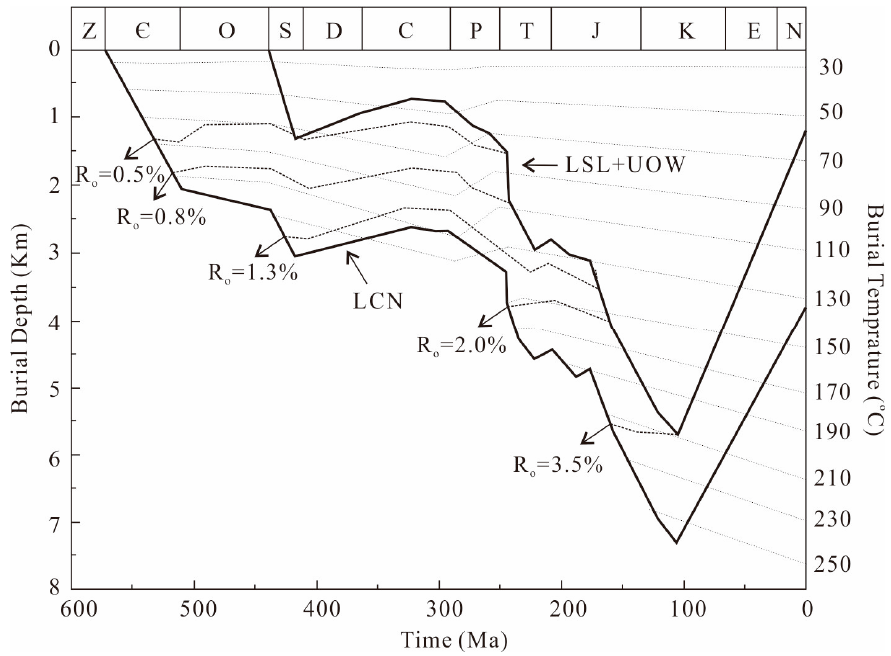
Figure 9. The burial history of LSL, UOW and LCN in the study area. (Modified from Tao et al. [36]).